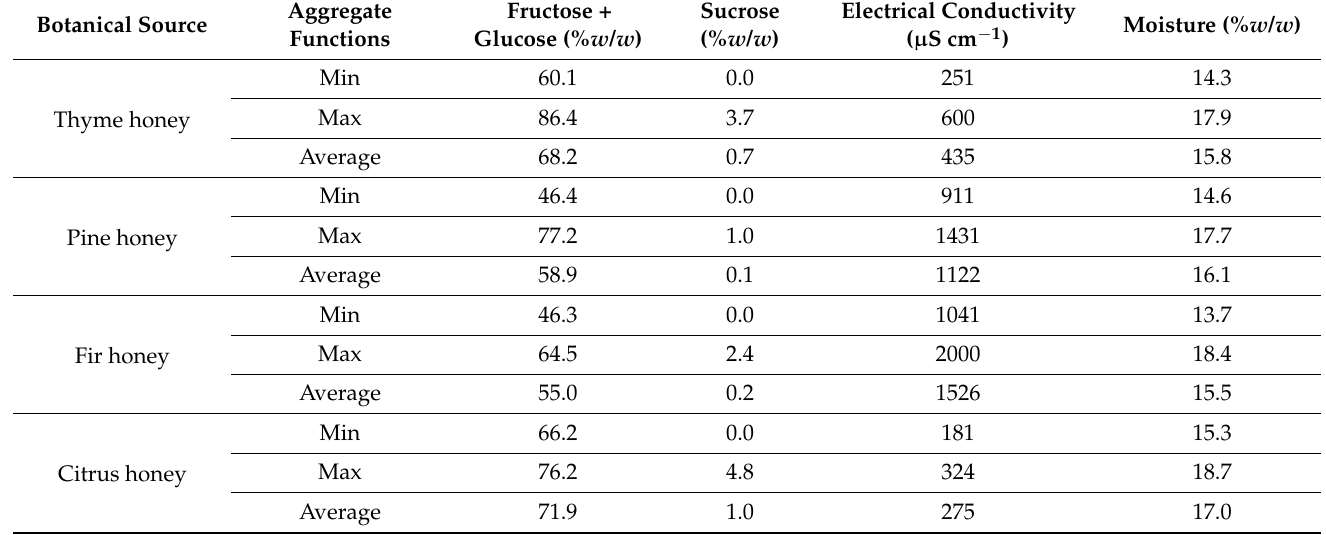
Table 1. Results of physicochemical analysis.